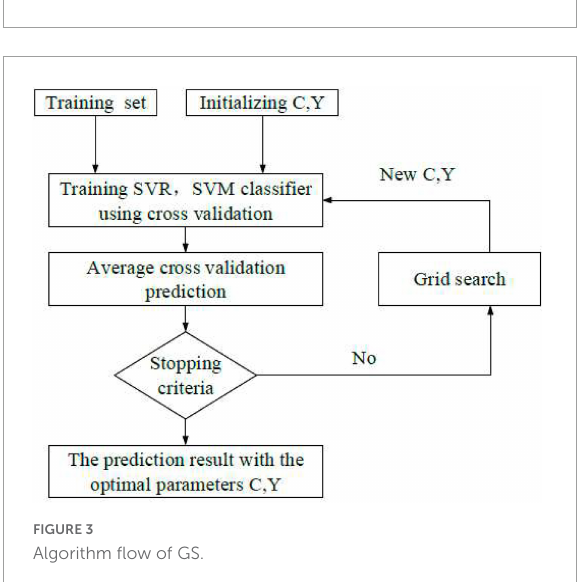
FIGURE3 Algorithm flow of